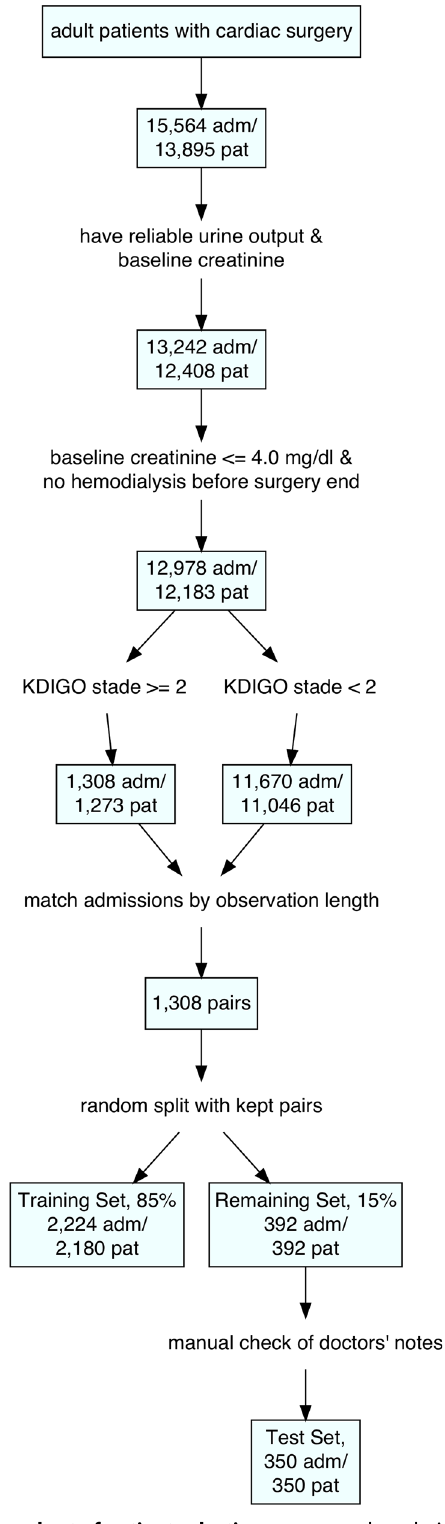
Fig. 3 Flow chart of patient selection process. adm admissions, pat